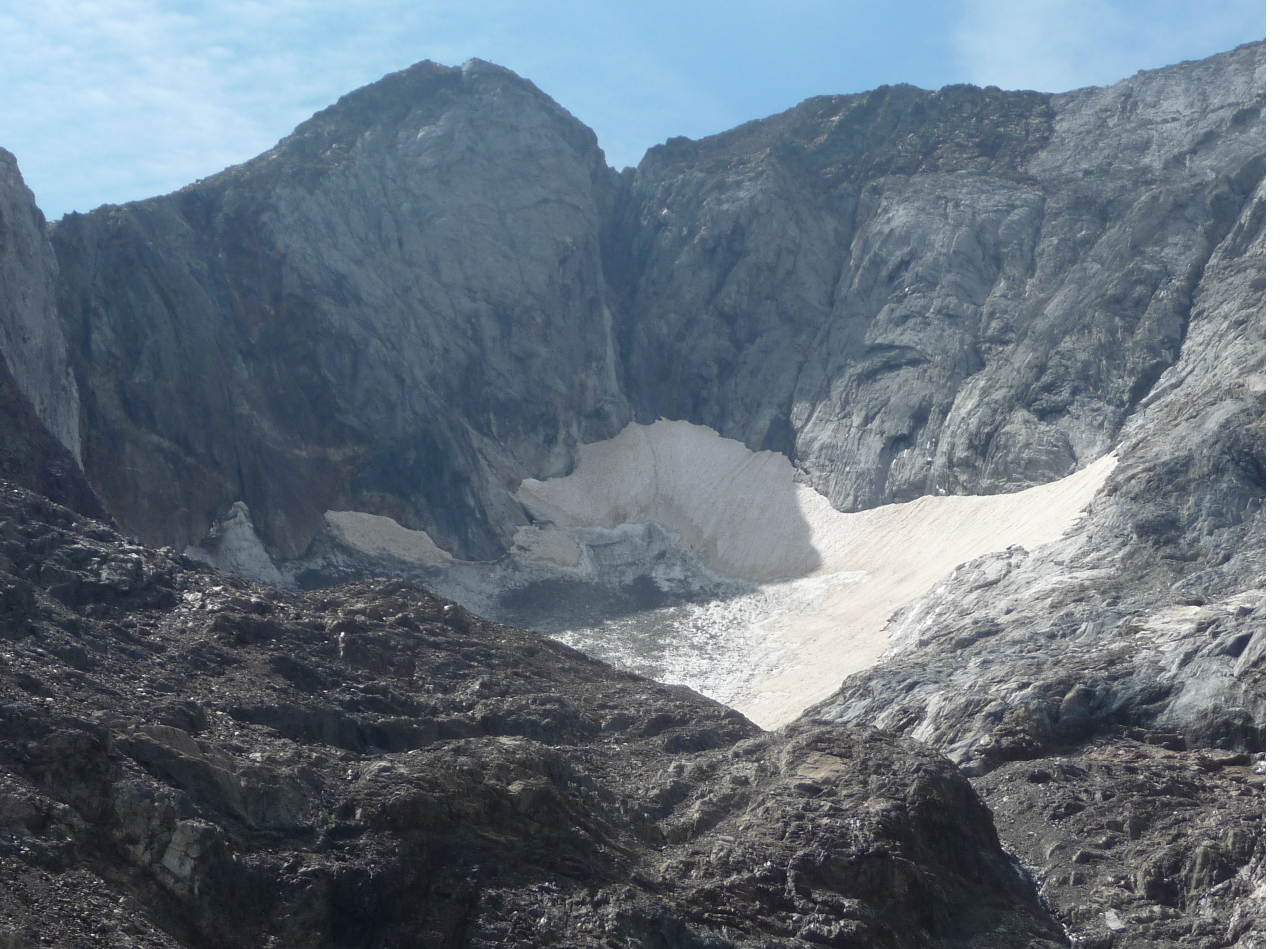
Figure 4. Mid-upper sector of the Infierno Glacier. The eastern sector shows a progressive transition to a debris-covered glacier. 5 September